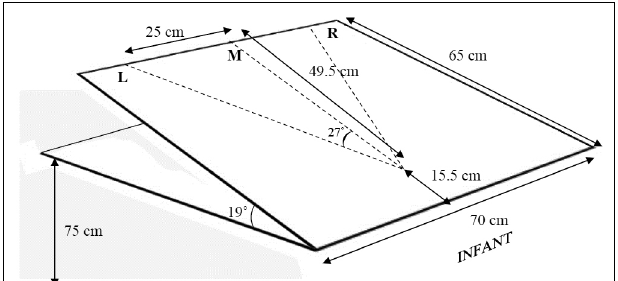
FIGURE 2 | The experimental